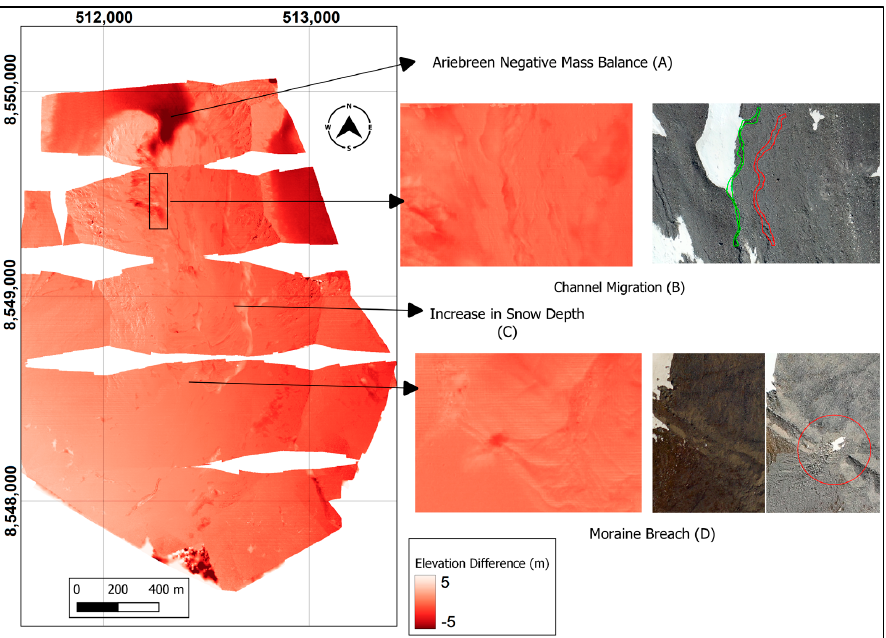
Figure 15. The differences between drone DEM from 2022 and SIOS DEM from 2020 in the Arie catchment. The arrows indicate the areas with detected changes due to negative geodetic glacier mass balance ( A ) and river channel migration ( B ), where the June 2022 extent is shown in green, and the June 2020 extent is shown in red; the increase in snow depth ( C ), and moraine breach location ( D ).